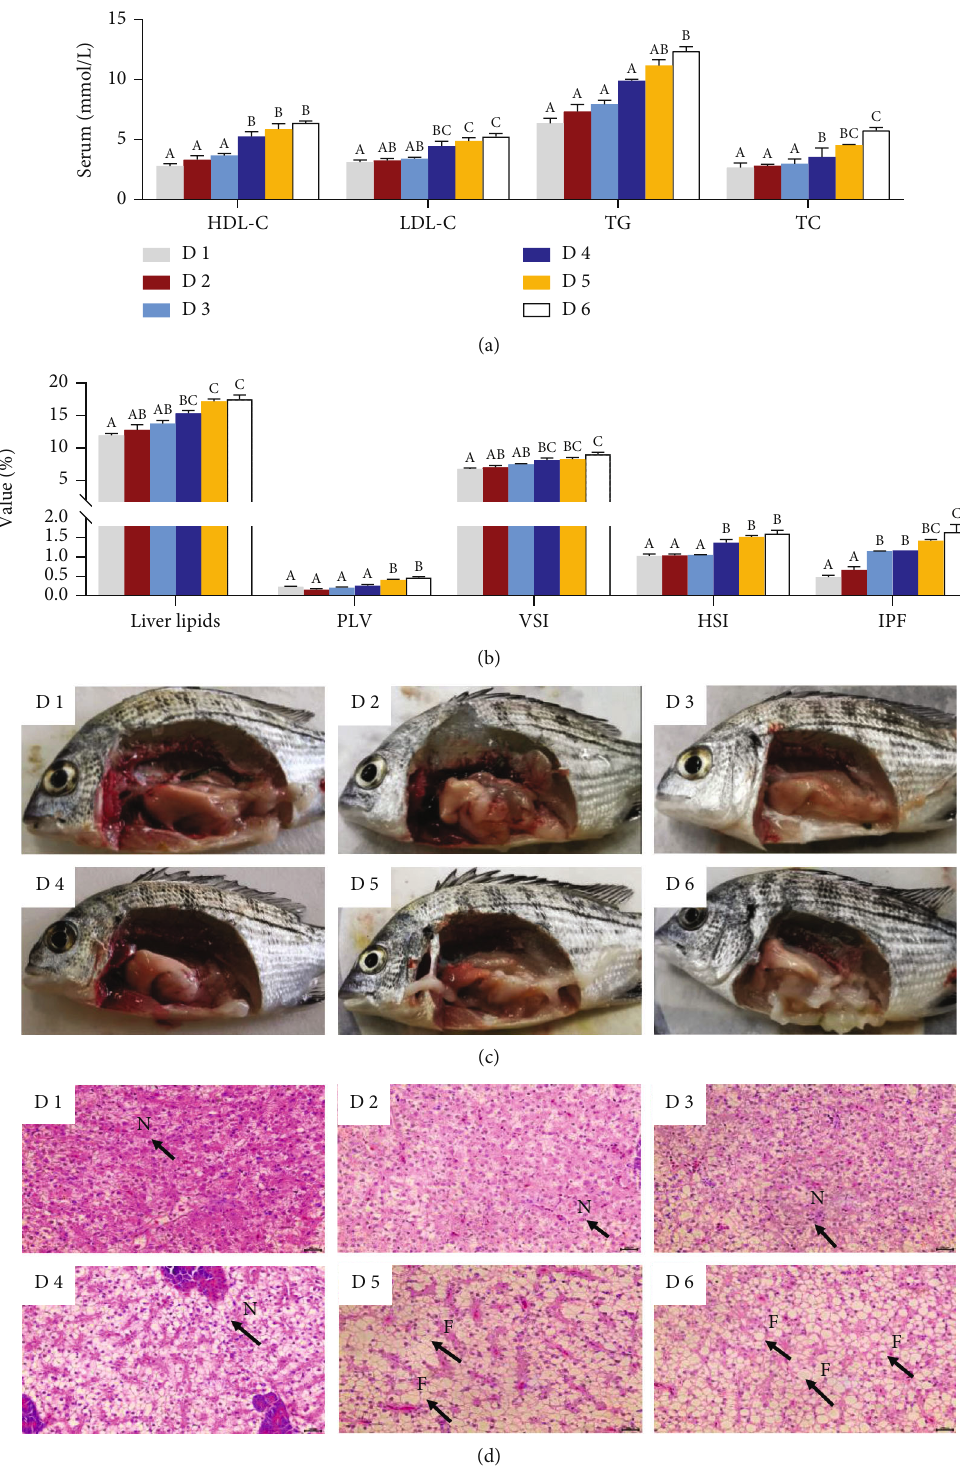
Figure 4: E ff ects of dietary lipid levels on serum biochemical indices and lipid accumulation of juvenile Acanthopagrus schlegelii reared at low-salinity water. Serum biochemical indices (a), lipid contents in the liver, PLV in para ffi n section of the liver, and morphology index (b), mesenteric fat (c), and para ffi n section of the liver with hematoxylin and eosin staining ( × 400, bar = 20 μ m) (d). Values are means ( n = 3 ), with standard errors represented by vertical bars. Mean values for the same column with di ff erent superscript letters were signi fi cantly di ff erent ( P < 0 : 05 ). F: lipid droplet vacuole; HDL-C: high-density lipoprotein cholesterol; HIS: hepatosomatic index; IPF: intraperitoneal fat ratio; LDL-C: low-density lipoprotein cholesterol; N: nucleus; PLV: percentage of lipid vacuoles; TG: triacylglycerol; TC: total cholesterol; VSI: viscerosomatic